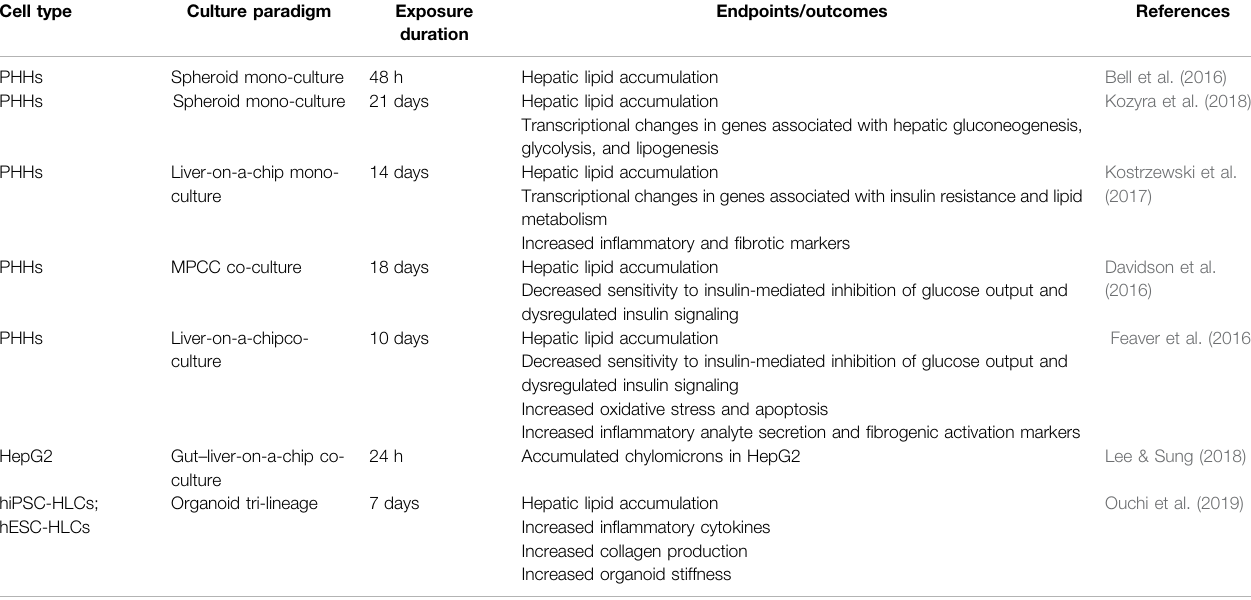
TABLE 3 | Selected 3D NAFLD models established from different cell